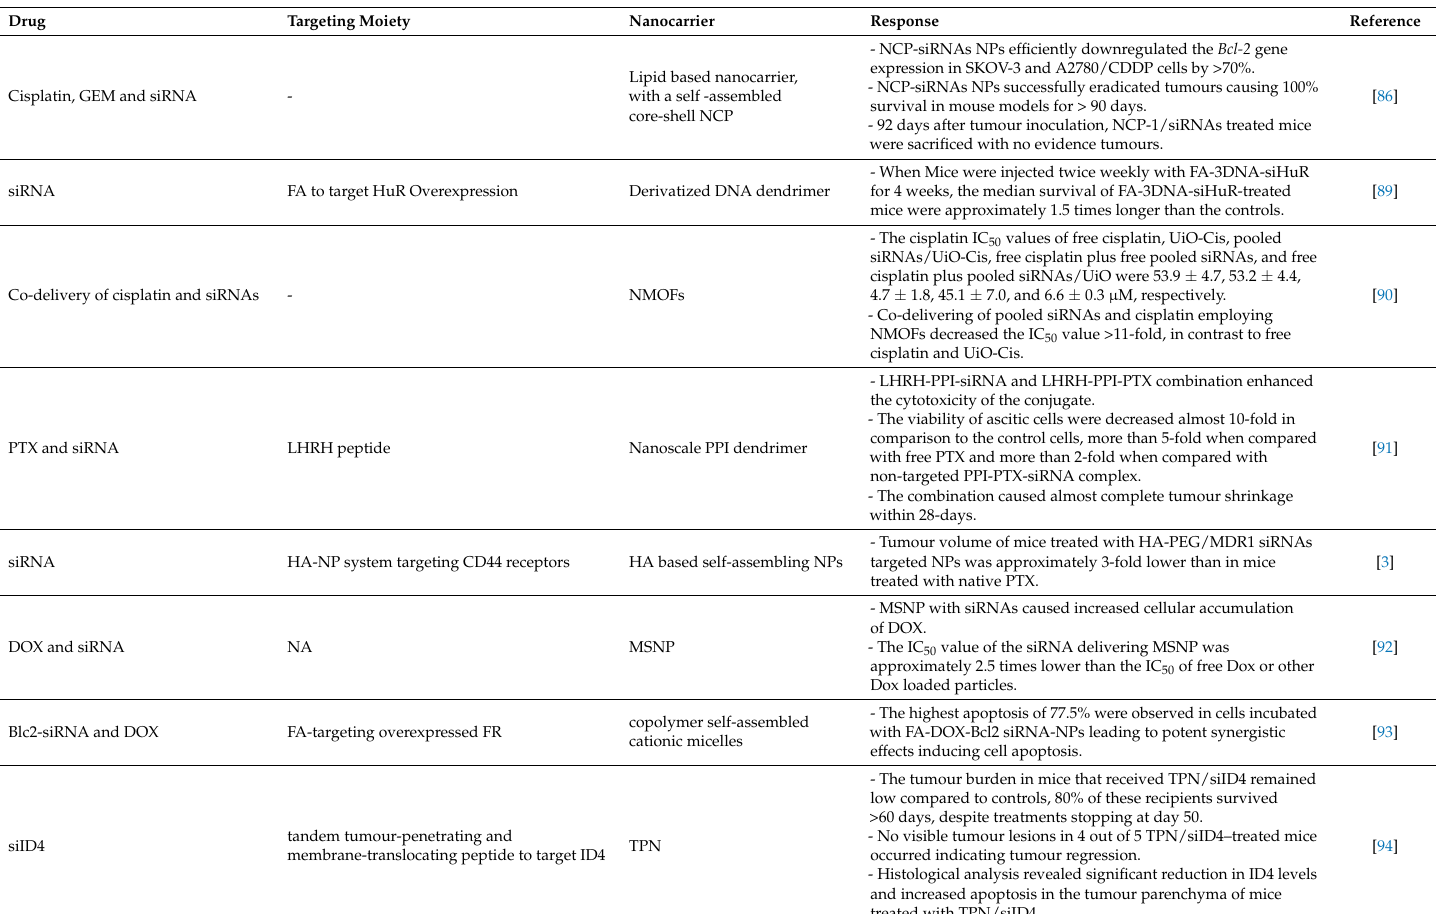
Abbreviations in the table are defined as follows: NMOFs, nanoscale metal − organic frameworks; GEM, gemcitabine; LHRH, luteinizing hormone-releasing hormone peptide; PPI, polypropylenimine; PTX, paclitaxel; CD44, Cluster of differentiation 44; HA-NP, Hyaluronan Nanoparticle; DOX, Doxorubicin; MSNP, mesoporous silica nanoparticles; siID4, ID4-specific siRNA; TPN, tumour penetrating